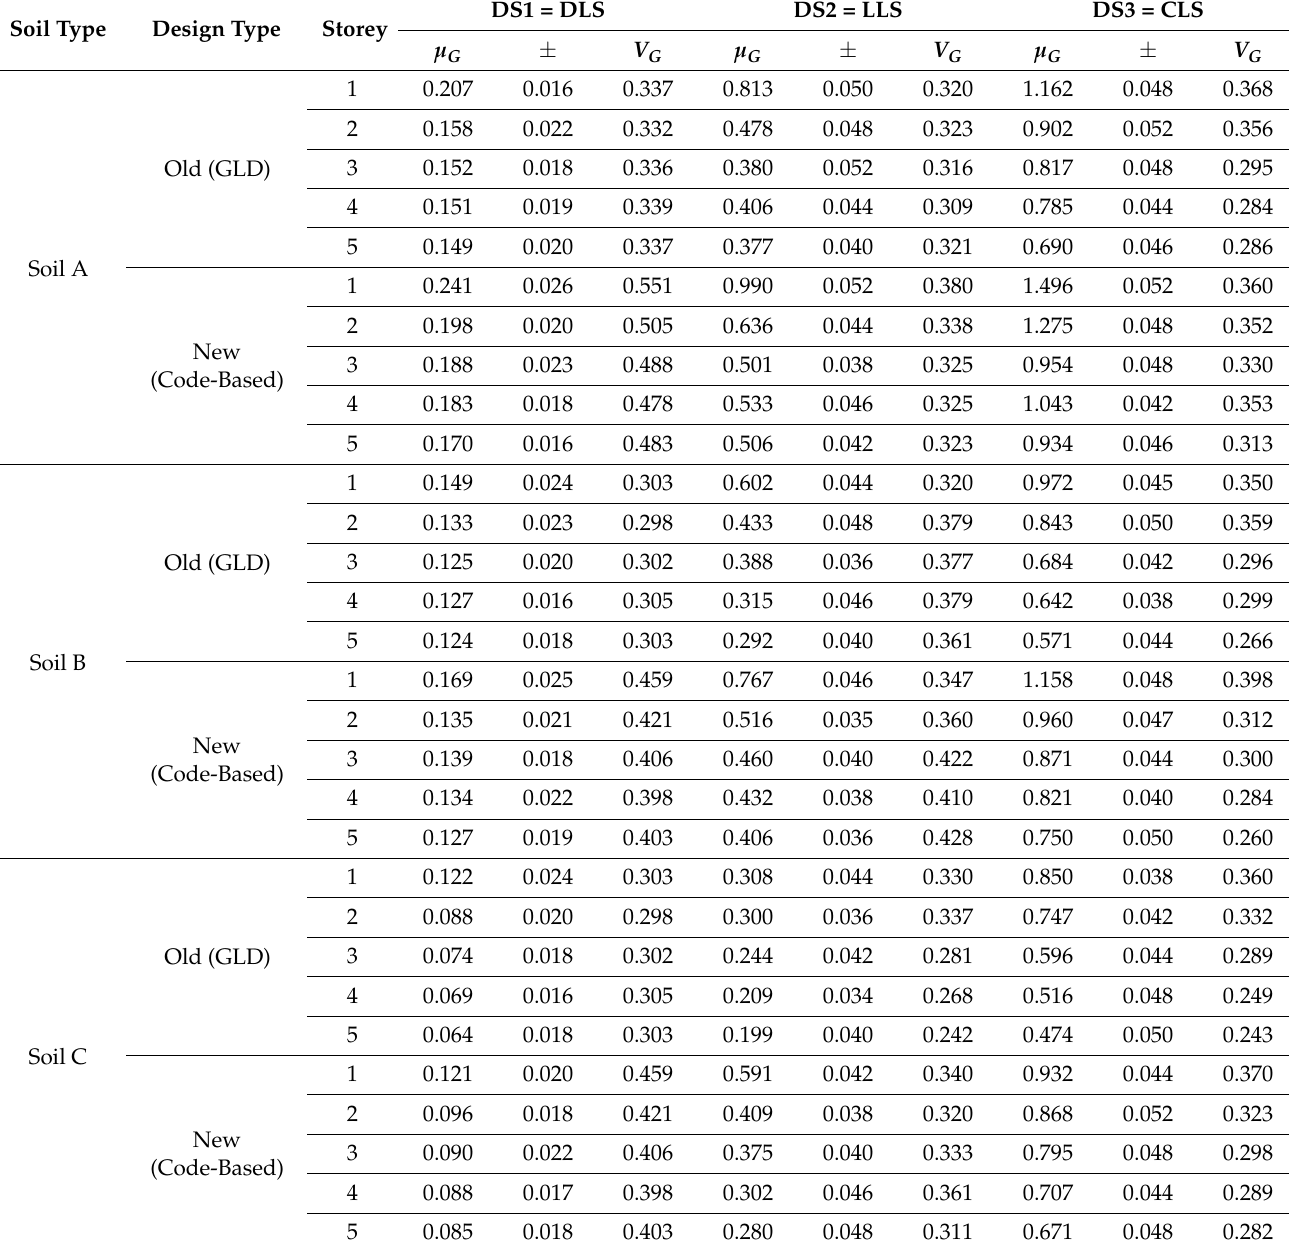
Table 5. Fragility curve parameters (mean µ G , fuse width around the mean, and coefficient of variation V G of the PGA-based capacity) for three Damage/Limit States, for three soil types (A, B, C), two construction types (“Old”, Gravity Load Design, and “New”, code-based design) and with number of storeys ranging from 1 to